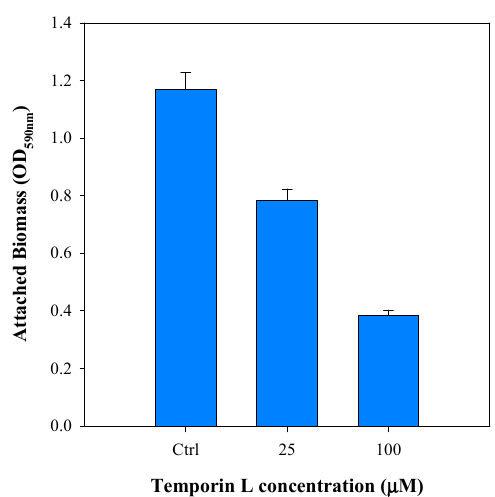
Figure 1. Estimation of attached biomass of 3 days-old-biofilms cultivated under stagnant fluid conditions using 12 well microplates (no glass substrates) upon TL treatment at two different concentrations (25 and 100 μ M). Data were calculated from three independent measurements and are reported as average; the standard deviations are indicated. Int. J. Mol. Sci. 2020 , 21 , x FOR PEER REVIEW